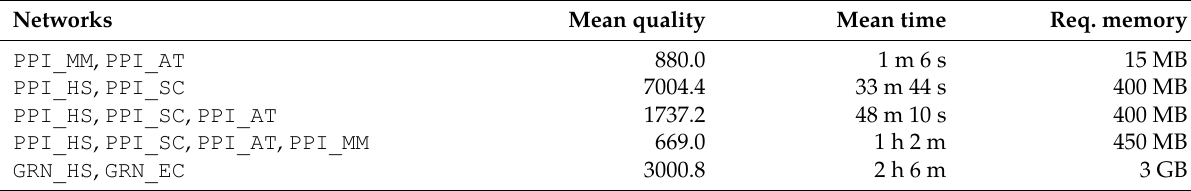
Table 2: Results of benchmark runs. Each test was repeated five times and mean quality and running time is reported. The solution quality is measured as the number of fully conserved